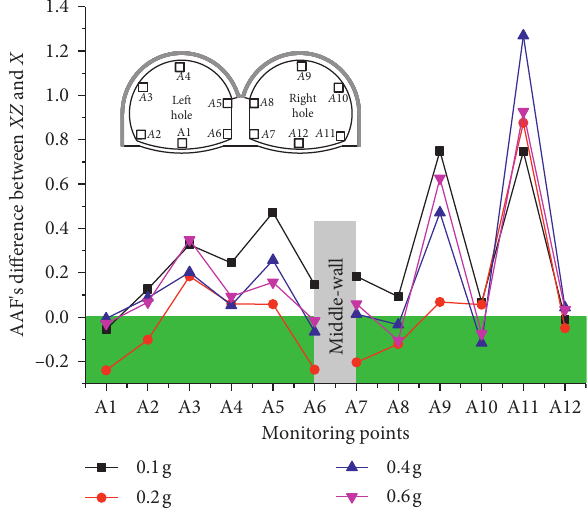
Figure 9: Variation trends of AAF of WC-X in the X -direction.